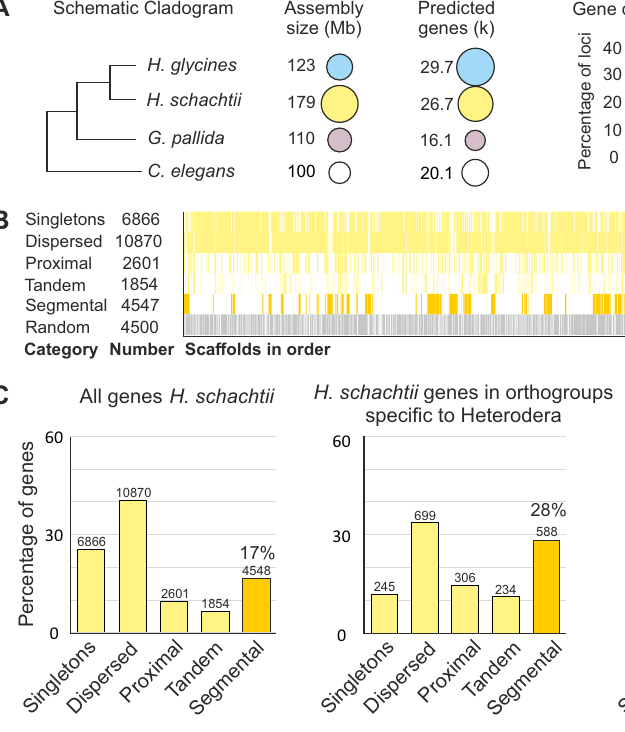
Fig. 2 | Large-scale segmental duplications in the Heterodera lineage acted on old and new genetic capital. A Schematic cladogram, assembly size, number of predicted genes, and gene duplication categories are shown for H. schachtii (yel- low), H. glycines (blue), G. pallida (purple), and C. elegans (white). B The genomic distribution of gene duplication categories. Each bar represents one gene. C Gene